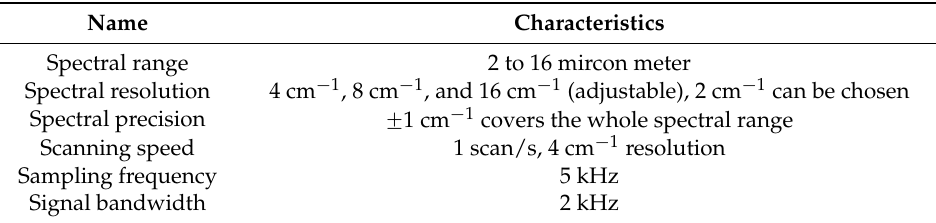
Table 1. Specifications of the 102F FTIR spectrometer.